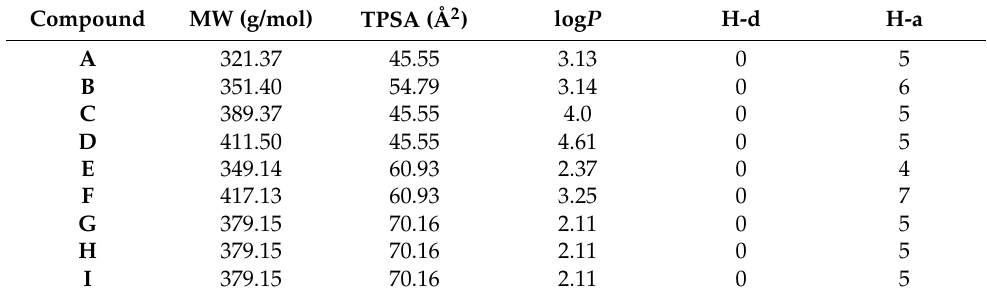
Table 1. Calculated values for molar weight (MW), TPSA, logP, H-d number, and H-a number for compounds A – I